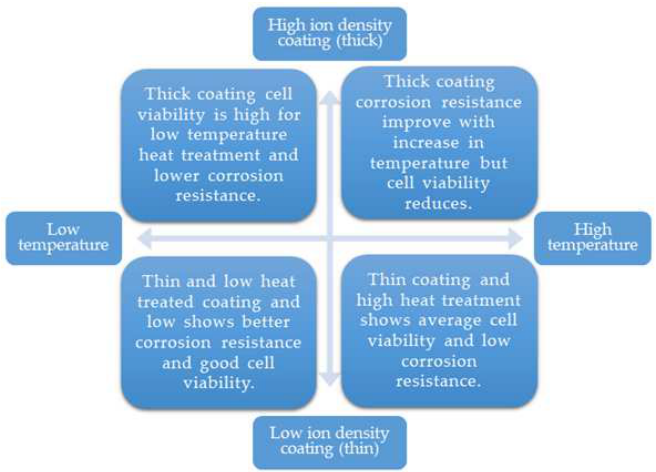
Figure 9. Effect of heat treatment and coating thickness on electrochemical property and osteoblastic cell viability.